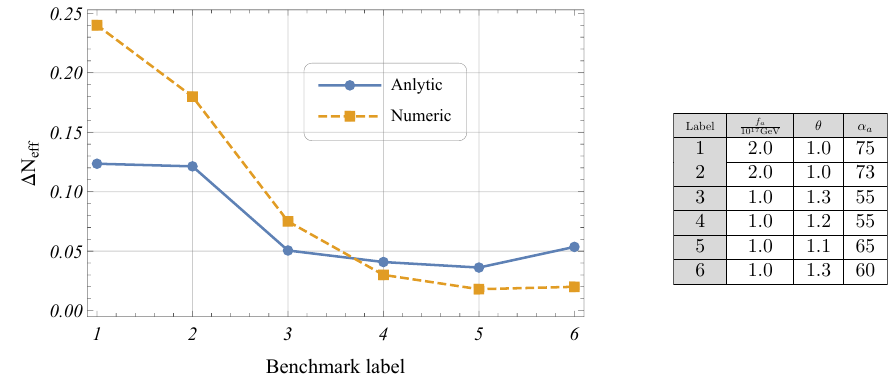
Figure 7 . Change in the effective number of relativistic degrees of freedom ( ∆ N eff ) due to pro- duction of dark photons. The analytic curve is obtained from eq. (2.56). The numerical data for different benchmarks is taken from ref. [62] and their details are presented in the